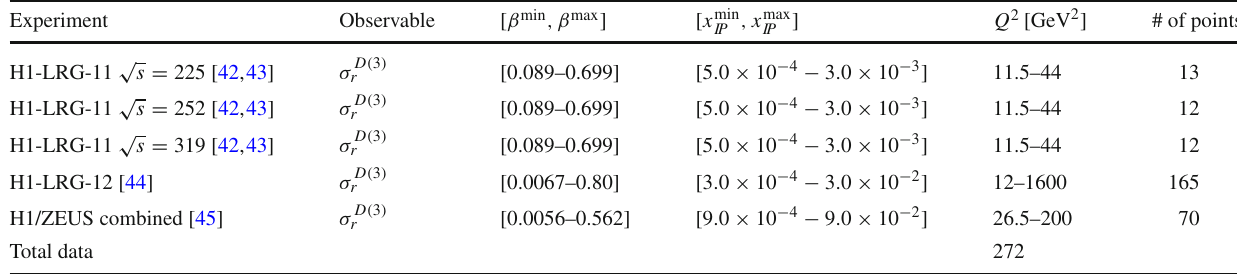
Table 2 List of all diffractive DIS data points used in Fit B global analysis. See the caption of Table 1 for more details